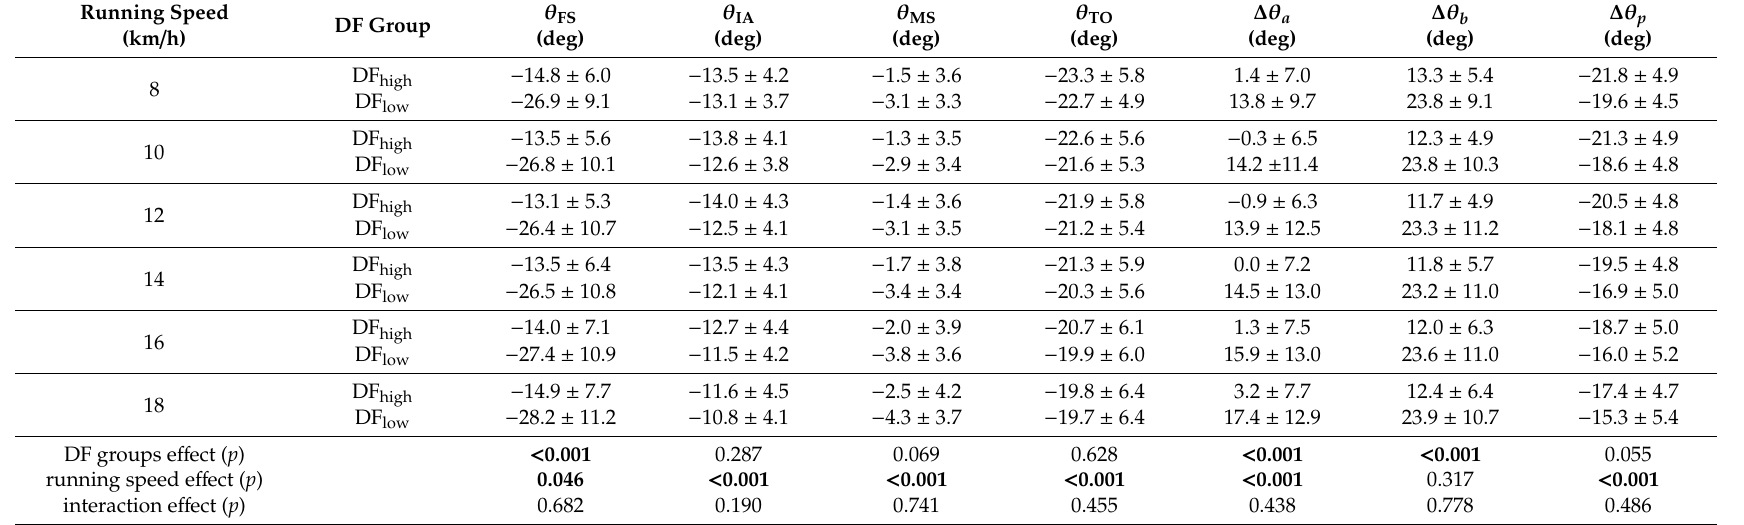
Table 5. Ankle extension–flexion joint angle at specific events of the running stance ( θ FS , θ IA , θ MS , and θ TO ) and their range of motions during the di ff erent running stance phases ( ∆ θ a , ∆ θ b , and ∆ θ p ) for the high (DF high ) and low (DF low ) duty factor running groups at the di ff erent running